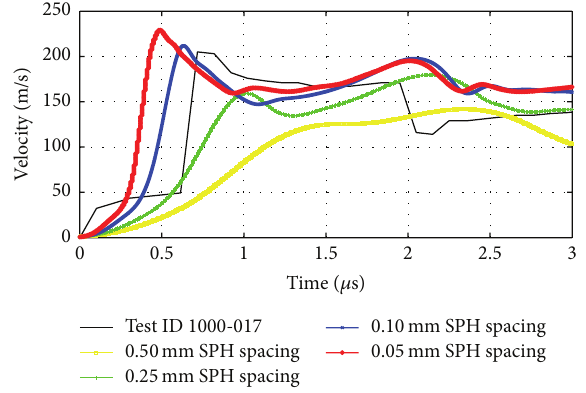
Figure 9: Typical SPH particle sensitivity study.